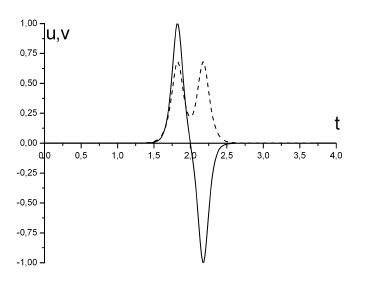
Figure 5. Shape of pulse for solitary wave on fundamental (solid line) and doubled (dashed line) frequency corresponding to the second eigenvalue for the following set of parameters: δ α = 0 , n α = 0 , δ γ = 0 , n γ = 0